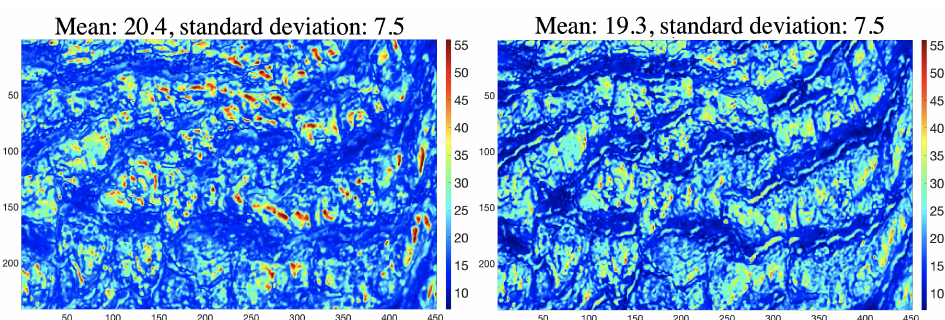
Figure 10. Example of fine details detection from surface roughness print of the wood image by SCIELAB in captures from the MS ( left ) and the SS ( right ). The images were cropped for illustration purpose. Zero means that there is no